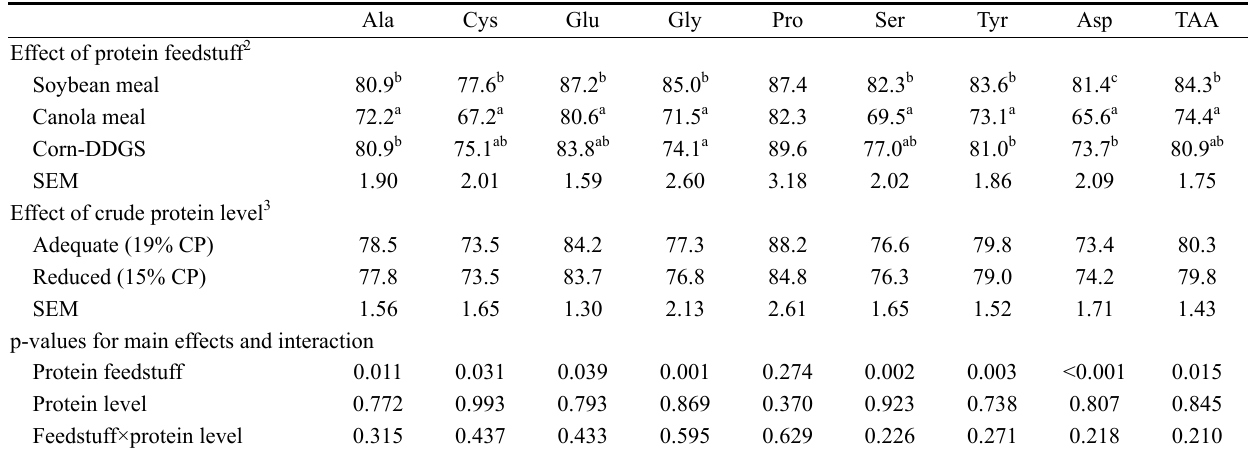
Table 7. Standardized ileal digestibility (%) of total- and dispensable amino acids in growing pigs in response to protein feedstuff used and crude protein level 1